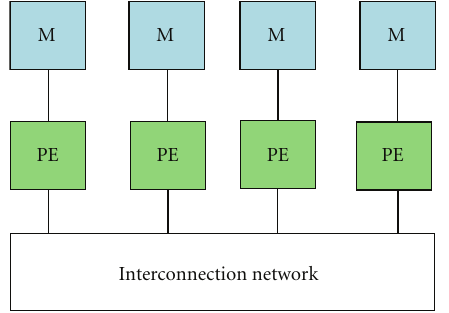
Table 3: Application-specific FPGA-Based multiprocessor